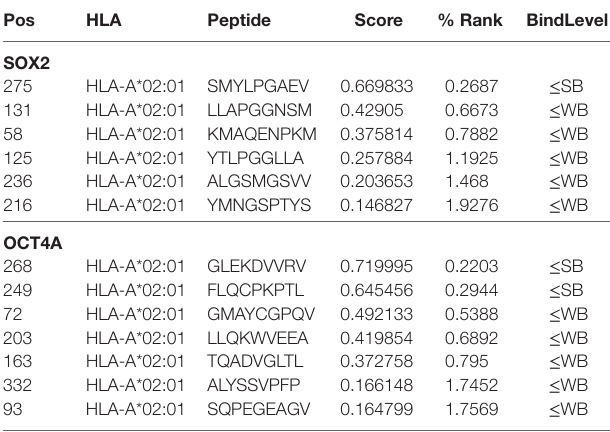
taBLe 2 | Predicted SOX2 and OCT4A peptides that bind to HLA-A. taBLe 1 | Predicted peptides from NANOG that bind to the most common